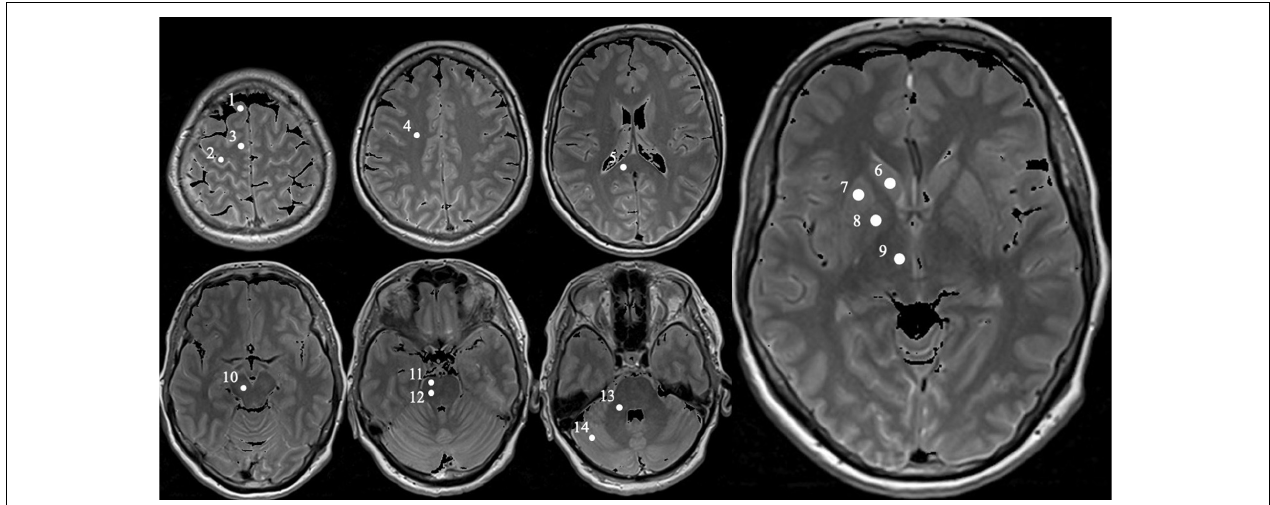
FIGURE 1 | Exemplary MRI with definition of the specific measured regions obtained from a PD patient (female, 62). Positions of each selected ROI in the right brain hemisphere marked as white circle on proton density weighted MR images obtained from a 62-year-old female Parkinson’s disease patient. The circles are numbered 1 to 14, representing the following ROIs: prefrontal subcortical area (1), subcortical primary motor area (2), supplementary motor area (3), centrum semiovale (4), splenium corporis callosi (5), nucleus caudatus (6), putamen (7), globus pallidus (8), thalamus (9), mesencephalon (containing substantia nigra and ventral tegmental area, 10), upper and lower pons (11 and 12, respectively), cerebellar white matter (13), and cerebellar posterior lobe (14).